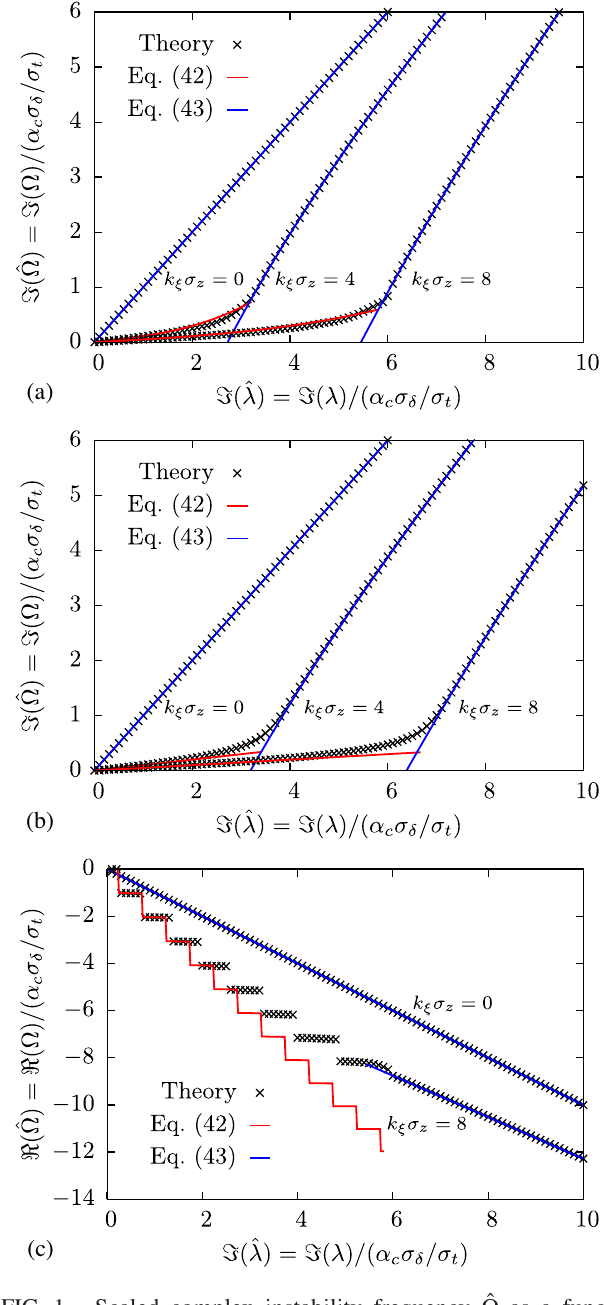
ˆ Ω FIG. 1. Scaled complex instability frequency as a func- ˆ λ tion of the scaled ξ ¼ 0 matrix growth rate ℑ ð Þ for three values of the chromatic phase k ξ σ . Panel (a) plots the z instability growth rate assuming that ℜ ð λ Þ ¼ ℑ ð λ Þ , where the diagonal crosses are the full theory Eq. (32), while the red and blue lines show the approximate, limiting Eqs. (42) and (43), respectively; panel (b) plots the same when the matrix eigenvalue is pure imaginary. Panel (c) plots the ˆ Ω instability frequency ℜ ð Þ when ℜ ð λ Þ ¼ ℑ ð λ Þ , showing that the unstable mode oscillates at a harmonic of ω if s λ ≲ 3 ξω σ 4 , but is not well described by a single synchro- 0 δ = tron mode when Eq. (43)